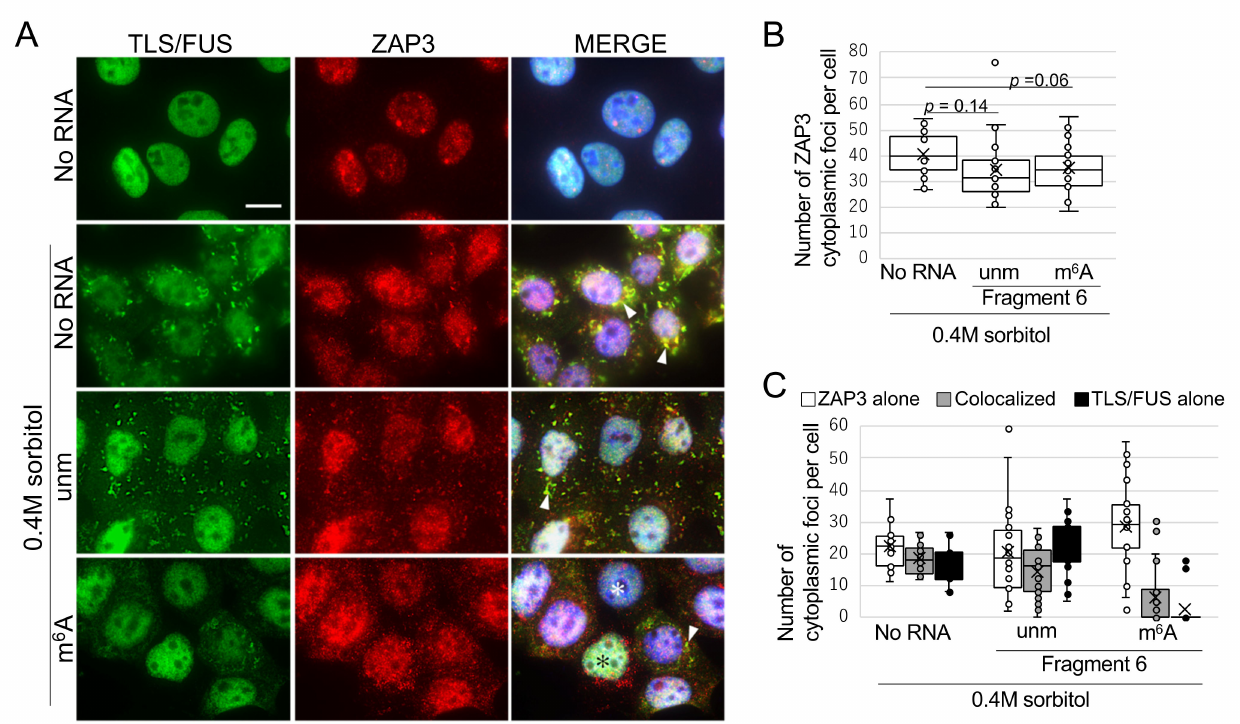
Figure 6. ZAP3 colocalized with cytoplasmic TLS/FUS foci after sorbitol treatment, but m 6 A-modified RNA fragment impaired this colocalization. ( A ) RNA Fragment 6 with or without m 6 A modification was transfected to HAP1 cells prior to 0.4M sorbitol treatment. Representative images of ICC are shown. MERGE images indicate the layered images of TLS/FUS, ZAP3, and DAPI (for nuclei staining). White arrowheads, colocalized TLS/FUS and ZAP3 foci; ∗ , cells with cytoplasmic ZAP3 foci independent of TLS/FUS. Scale bar = 10 µ m. ( B , C ) Cytoplasmic foci in ( A ) were quantified. n = 20. unm, unmodified fragment; m 6 A, m 6 A-modified